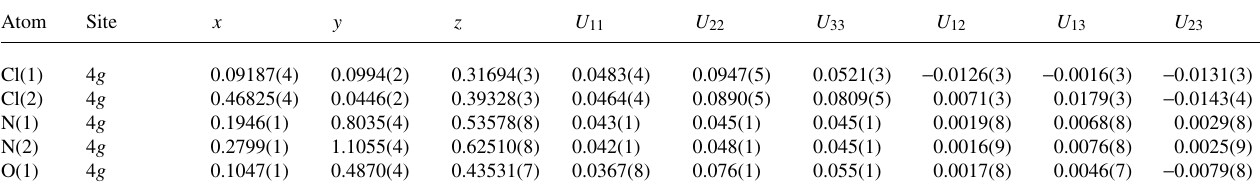
Table 3. Atomic coordinates and displacement parameters (in Å 2 )